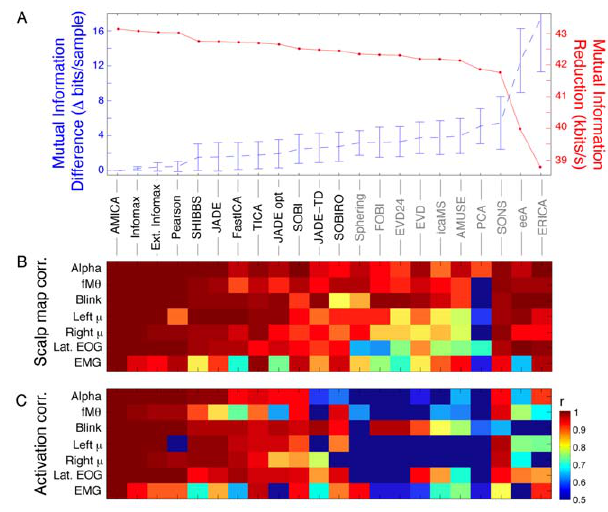
Figure 3. Correlations of component scalp maps and time courses across algorithms for the seven identified component types. A . (Blue trace) Mean ( 6 std. deviation across all data sets) additional mutual information remaining in the time courses of components returned by each of the 22 decomposition algorithms relative to AMICA decompositions of the same data, sorted left to right by overall degree of mutual information reduction (MIR, red trace). Names of the 12 algorithms returning components with more mutual information reduction (MIR) than simple sphering (bottom left) are lettered in black. B . Mean correlations between seven representative AMICA component scalp maps from one participant (same as top row in Figure 2 ) and the seven components with best absolute scalp map correlations to these returned by the other decompositions of this subject’s data. C . Mean correlations between the independent component activation time courses for the same component pairs as in B. Although the time course correlations are generally lower than scalp map correlations, the two patterns of results are similar, with (leftmost) decompositions effecting the most mutual information reduction returning components whose scalp maps and activities generally strongly resemble the selected AMICA